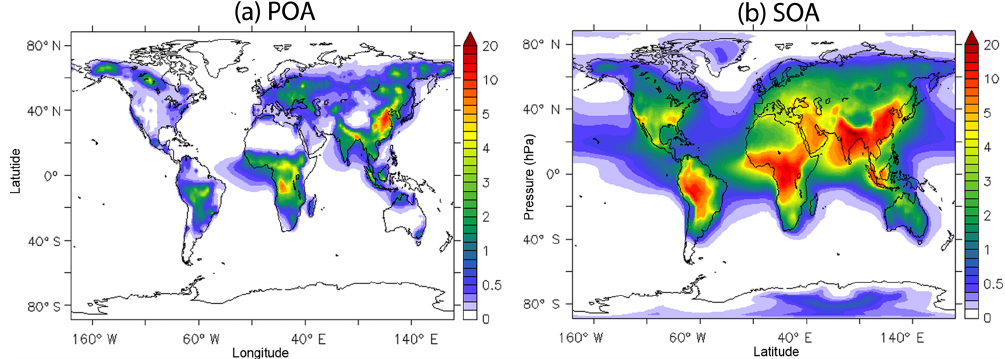
Figure 4. Predicted average surface concentration (in µgm − 3 ) of (a) POA and (b) SOA during the years 2001–2010.